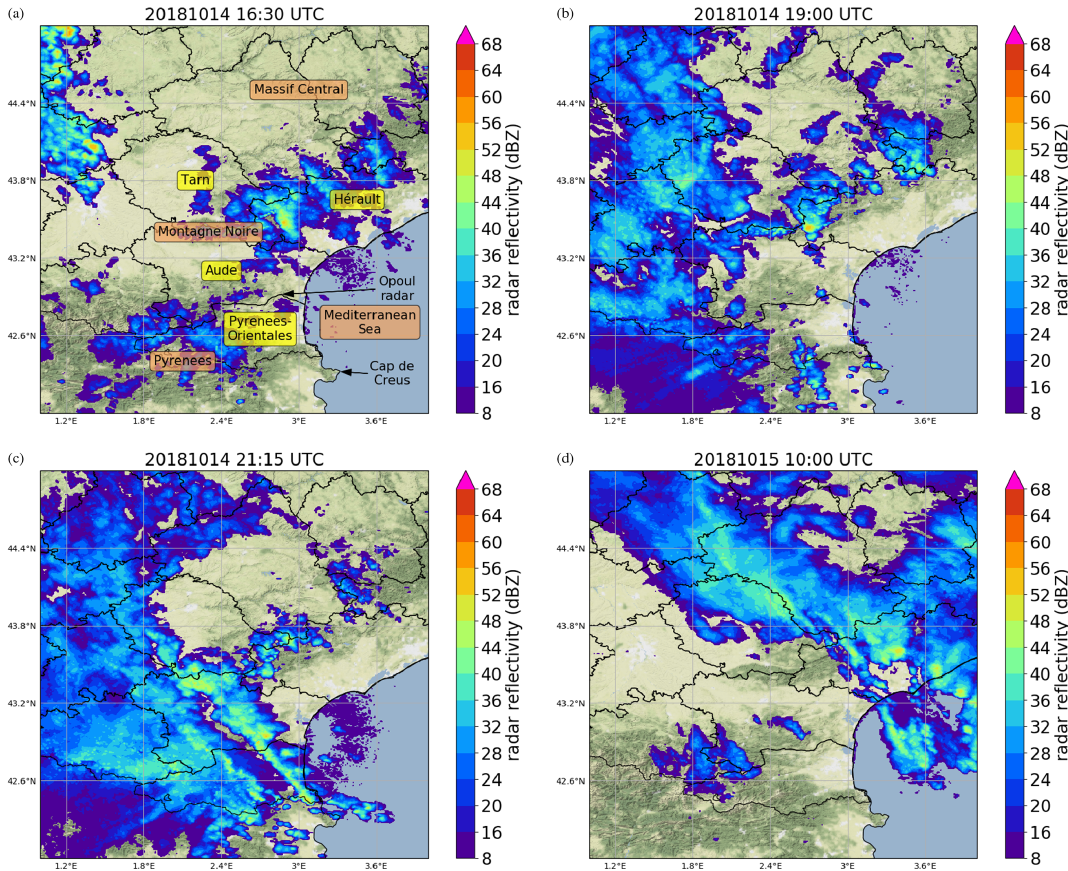
Figure 5. Base radar reflectivity (dBZ) (a) at 16:30UTC on 14 October; (b) at 18:55UTC on 14 October; (c) at 21:15UTC on 14 October; (d) at 09:55UTC on 15